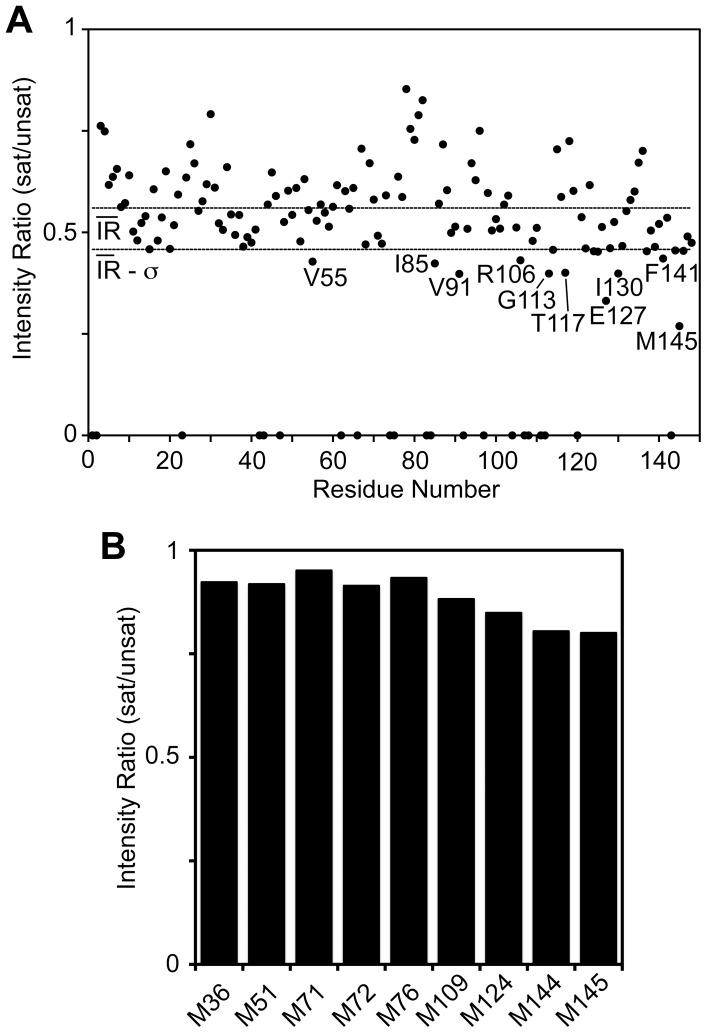
Identification of Apo-Lf Contacts on Ca2+-CaM from Cross-Saturation Data.
A) Plot of residue-specific cross-saturation-induced amide proton signal intensity changes for apo-Lf-bound Ca2+-CaM. The unassigned residues are shown as having an intensity ratio of zero. The two horizontal lines on the graph represent the statistical significance of the change seen for an individual residue. B) Cross-saturation-induced methionine ε-methyl signal intensity changes for apo-Lf-bound Ca2+-CaM.